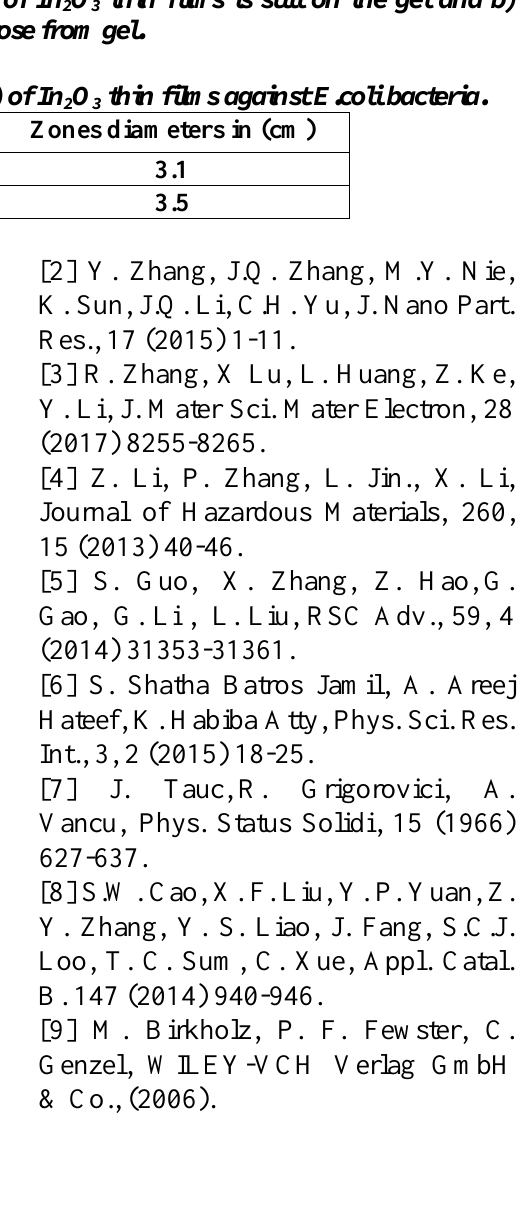
O thin films when is rose from gel. 2 3